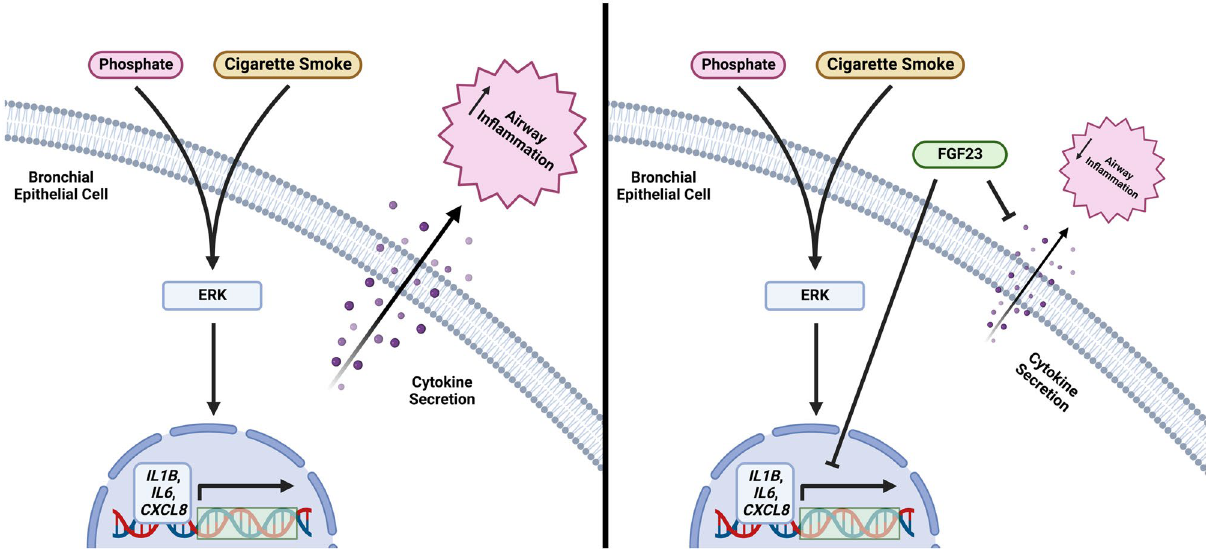
Figure 7. Schematic of the effects of high phosphate on proinflammatory cytokine expression and secretion in the presence of cigarette smoke/FGF23 in the bronchial